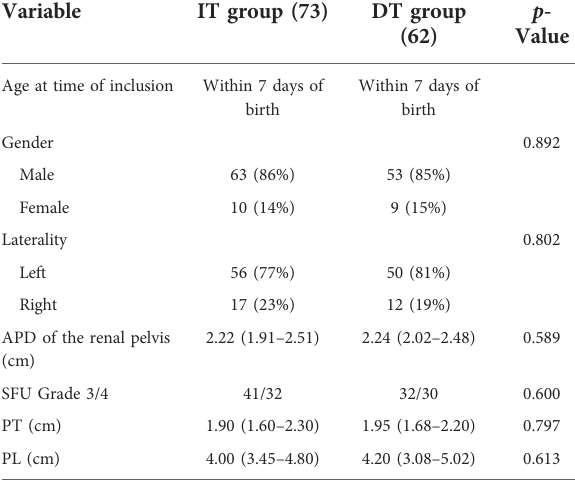
Table 1 . All infants with prenatal hydronephrosis had ultrasonography con fi rmation of UPJO within 7 days of birth. Of the patients, 86% of the children were boys, and 79% of UPJO occurred on the left lateral side. There were no TABLE 1 Initial characteristics of hydronephrosis in infants.